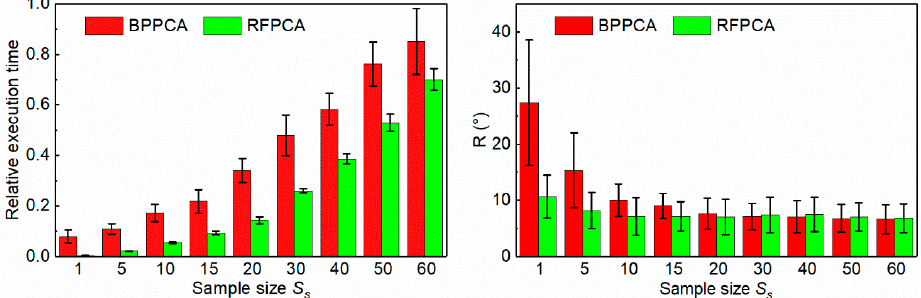
Figure 7. The relative execution time and R for the estimation with different S s .